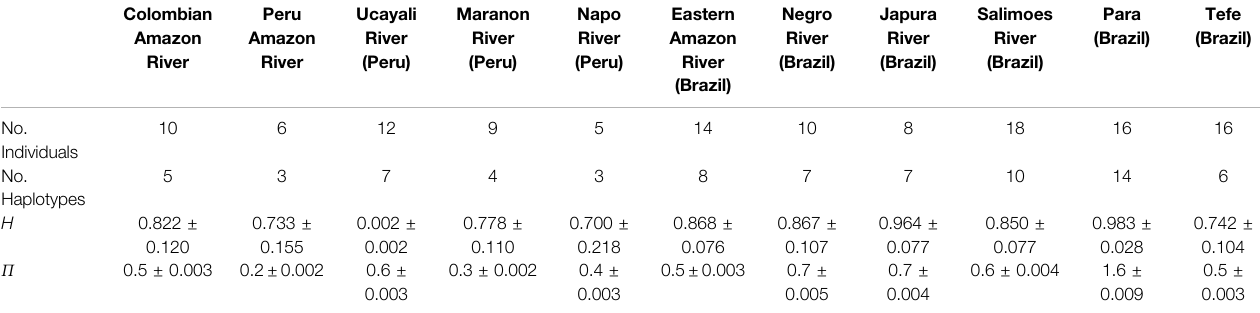
TABLE 4 | Genetic diversity statistics for T. inunguis . Haplotype diversity ( h ) and nucleotide ( π ) diversity (in %) are shown for each geographic location ( ± SD). Colombian Peru Ucayali Amazon Amazon River River River